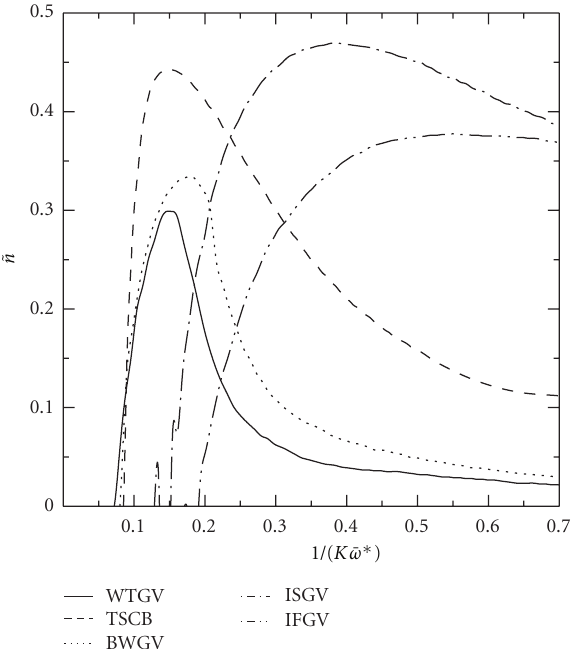
Figure 14: Comparison of starting characteristics under irregular wave conditions.